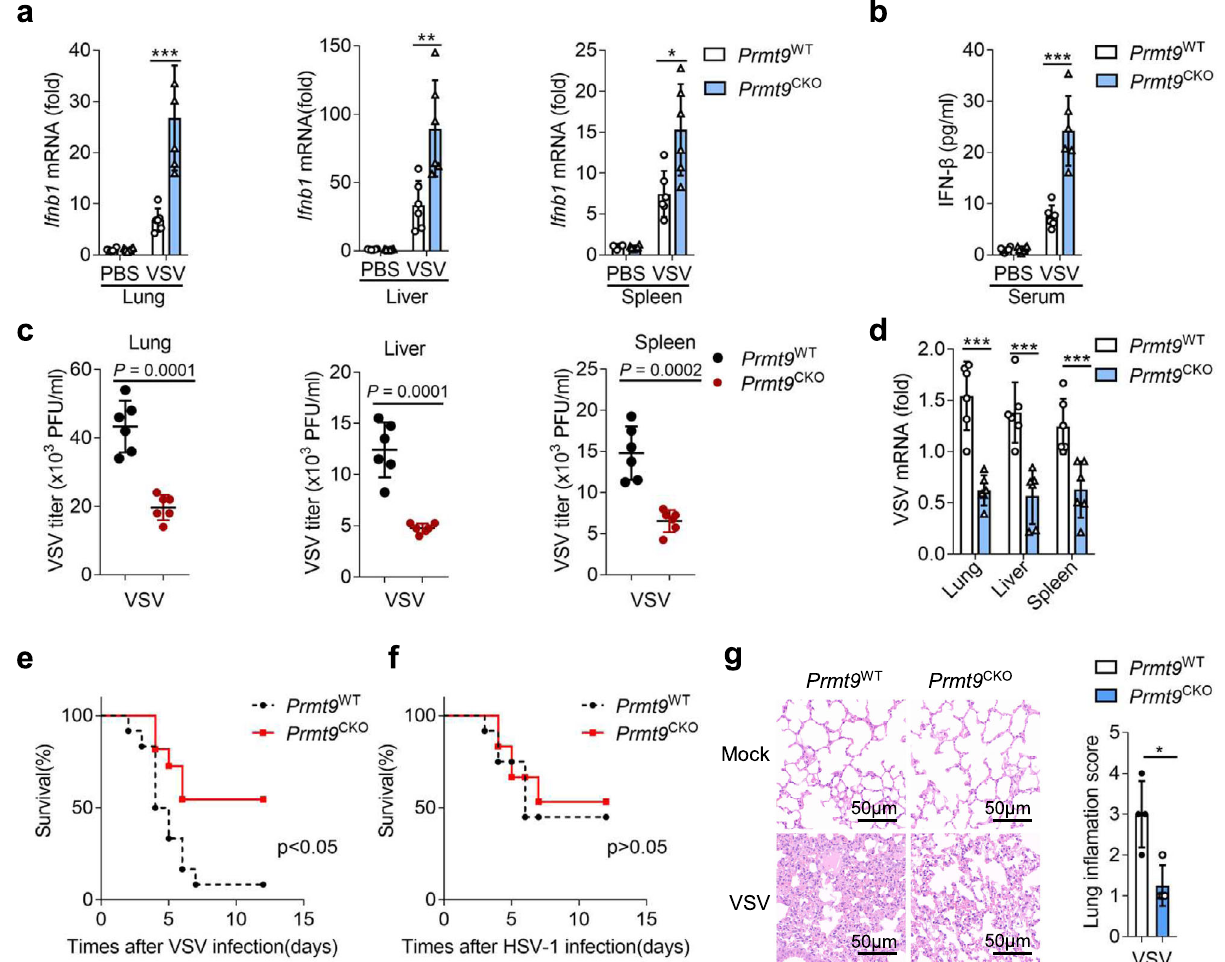
Fig. 3 | PRMT9 inhibits innate antiviral response in vivo. a – d Eight-week male Prmt9 CKO and Prmt9 WT mice were infected by tail vein injection with VSV (1.8×10 7 PFUpermouse)for24h ( n =6micepergroup). a qRT-PCR analysis of Ifnb1 mRNA in the lung (left, *** p =0.0009), liver (middle, ** p =0.0059), and spleen (middle, * p =0.0119). b ELISAanalysisofIFN- β proteininserum,*** p =0.0002.Plaqueassay ofVSVtiters( c )andqRT-PCRanalysisofVSVmRNA( d )inlung(left,*** p =0.0001), liver (middle, *** p =0.0005) and spleen (right, *** p =0.0028). e , f Survival of Prmt9 CKO and Prmt9 WT mice ( n =12 mice per group, 6 – 8 weeks old) after tail vein